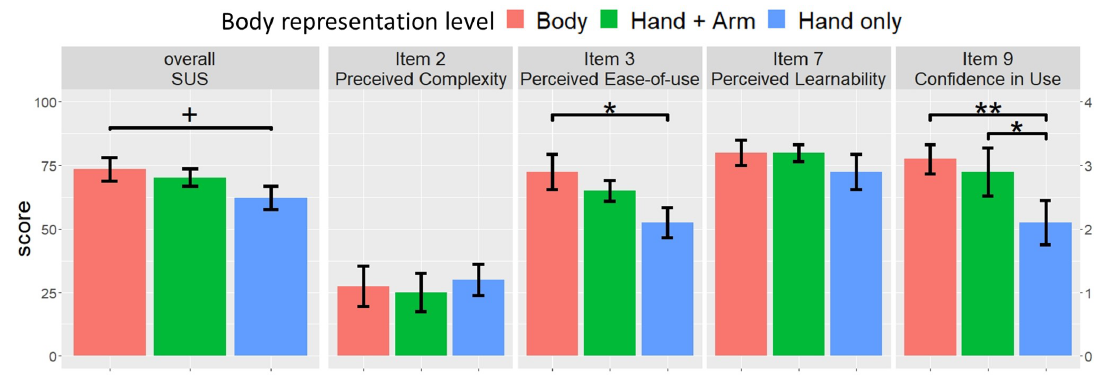
Figure 4. Overall SUS score and individual item scores (+ p < 0.1, * p < 0.05, ** p < 0.01). All error bars represent standard